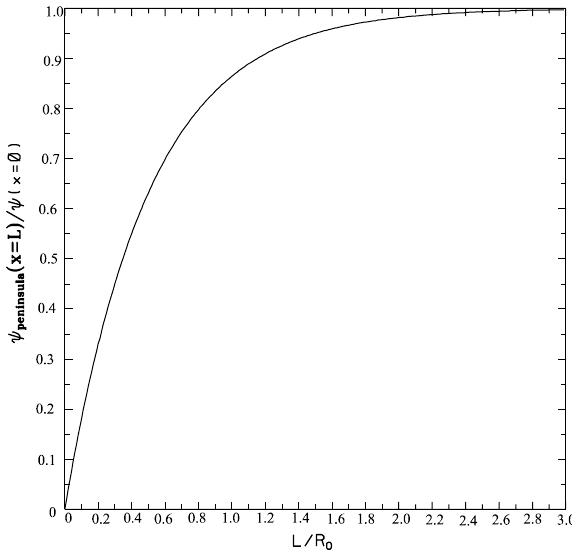
Fig. 2. Stream-function of two interacting breeze cells as a function of peninsula width. The stream-function of the peninsula is normalized to the stream-function of a single sea breeze